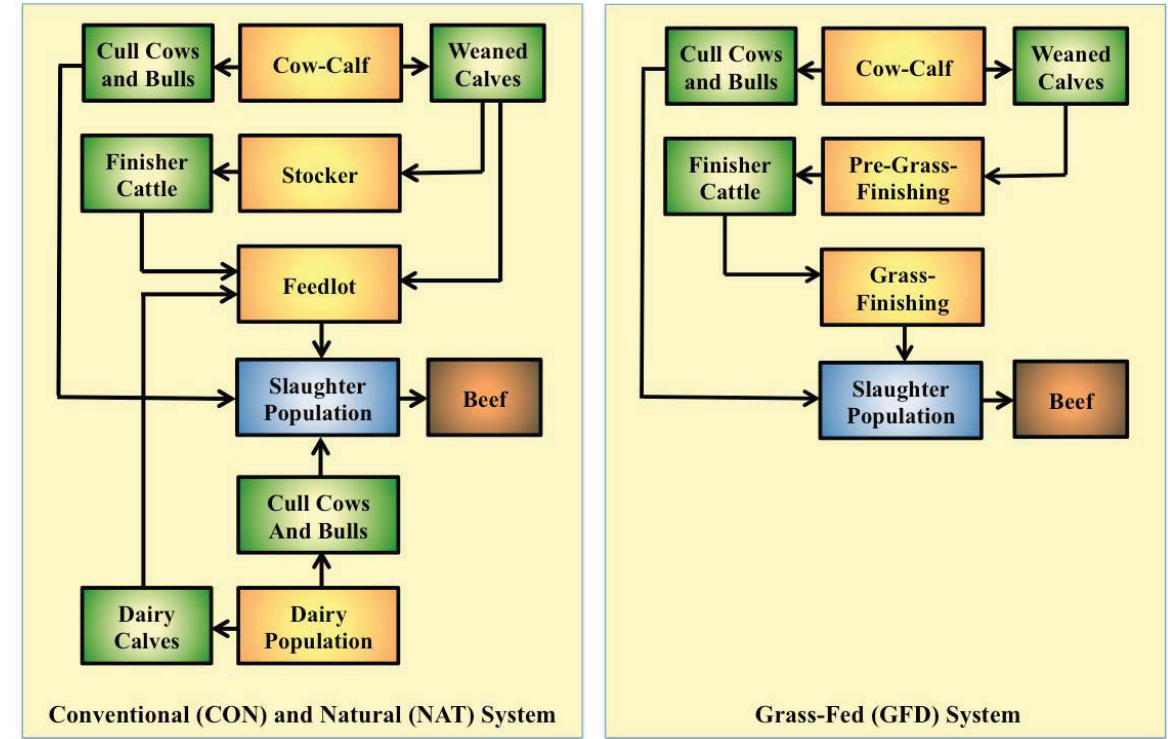
Figure 2. Schematic representation of the animal systems modeled within the